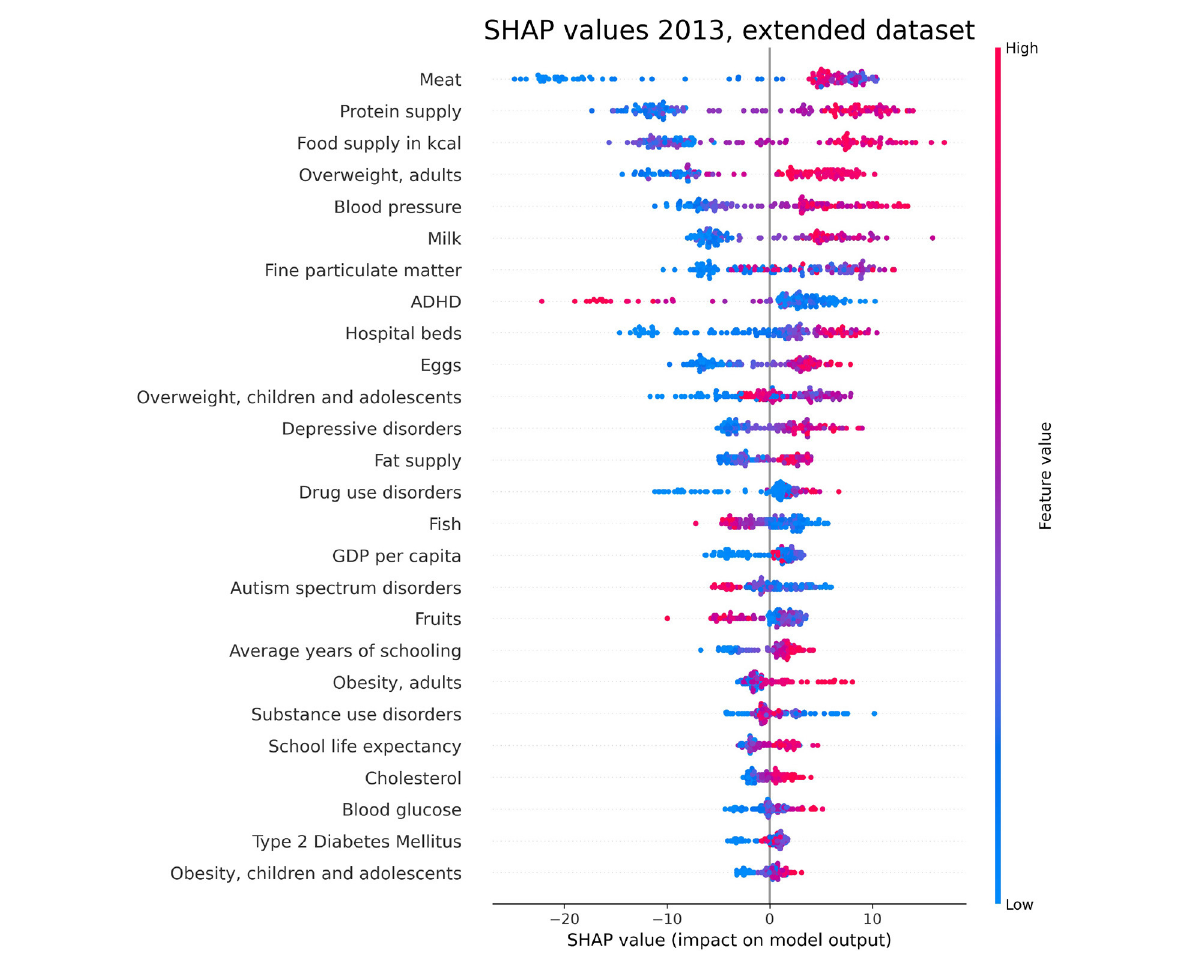
FIGURE10 SHAP values corresponding to the features that are most influential in the prediction of PAD for the year 2013, obtained with the extended dataset described in Section 3.6. Different points in the same row are associated to the prediction made for different countries.